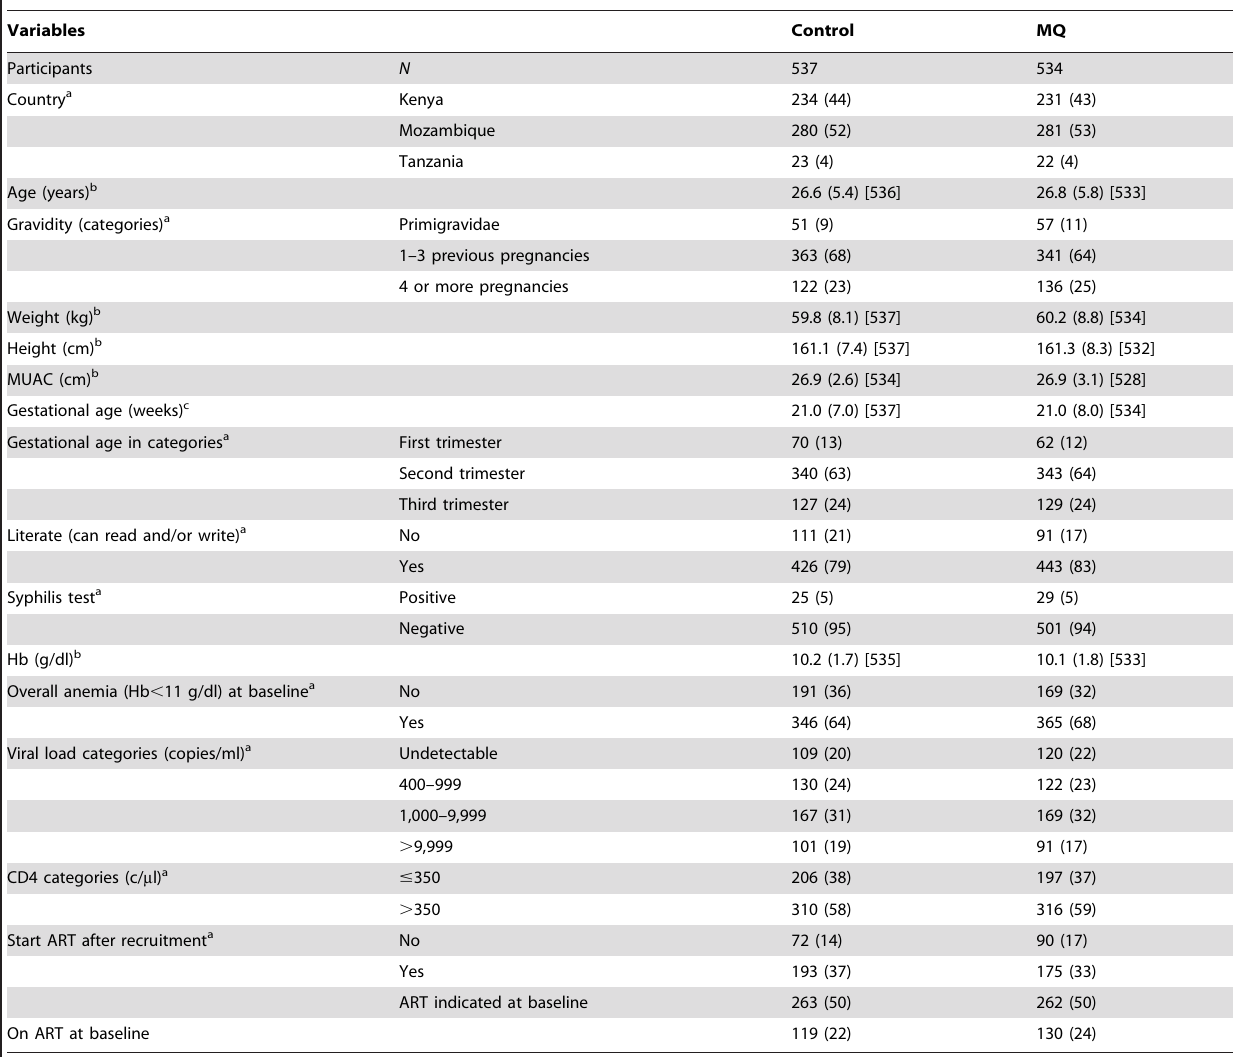
Table 1. Baseline